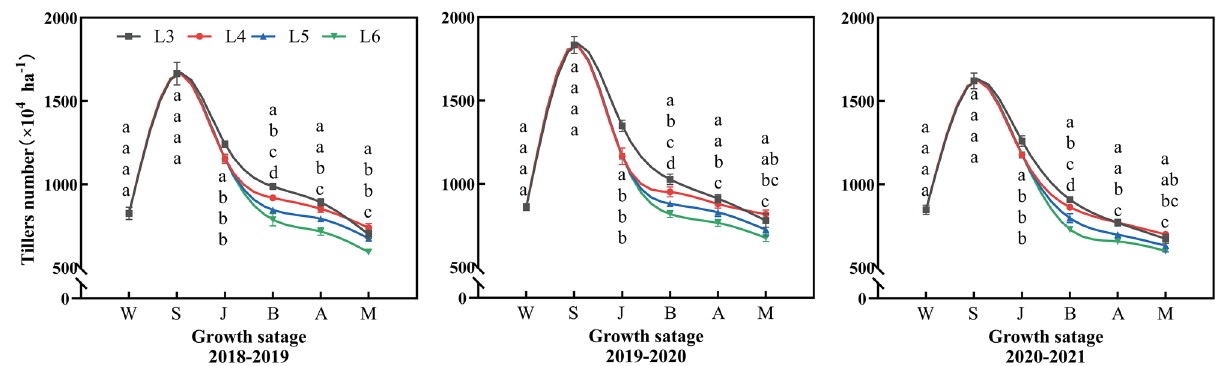
Figure 7. Dynamics of winter wheat tills number (× 107 ha-1) at different growth stages in 2018–2019 ( a ), 2019–2020 ( b ) and 2020–2021 ( c ). W, S, J, A, B and M indicate the growth stages of wintering, standing, jointing, booting, anthesis, and maturity, respectively. Each value represents the mean ± SE (n = 3). Bars showing the same letter are not significantly different at P ≤ 0.05 as determined by the LSD